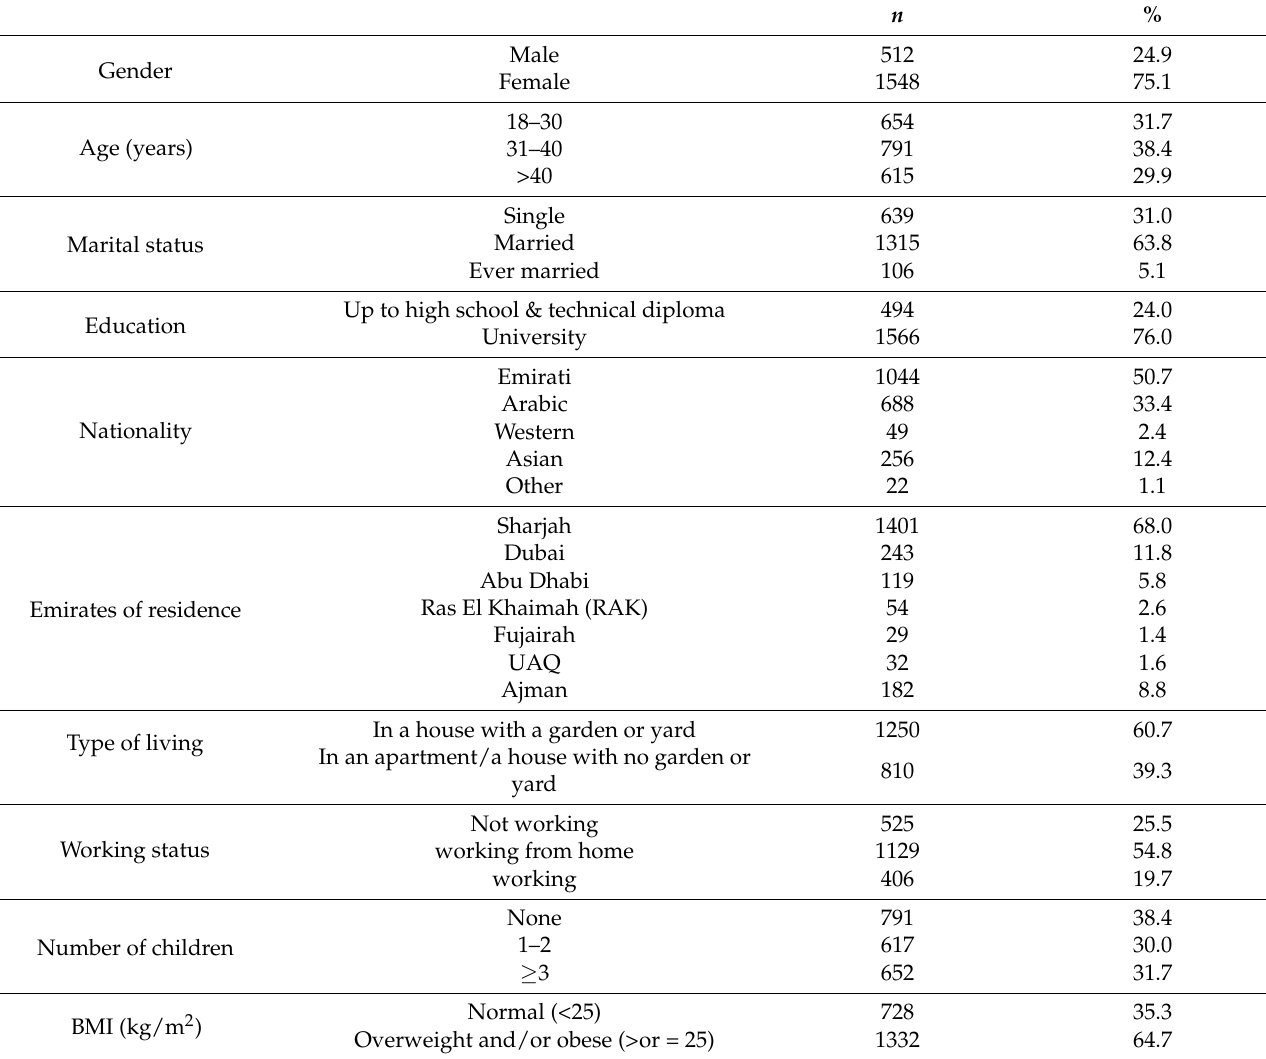
Table 1. Sociodemographic characteristics of the study population ( n = 2060).